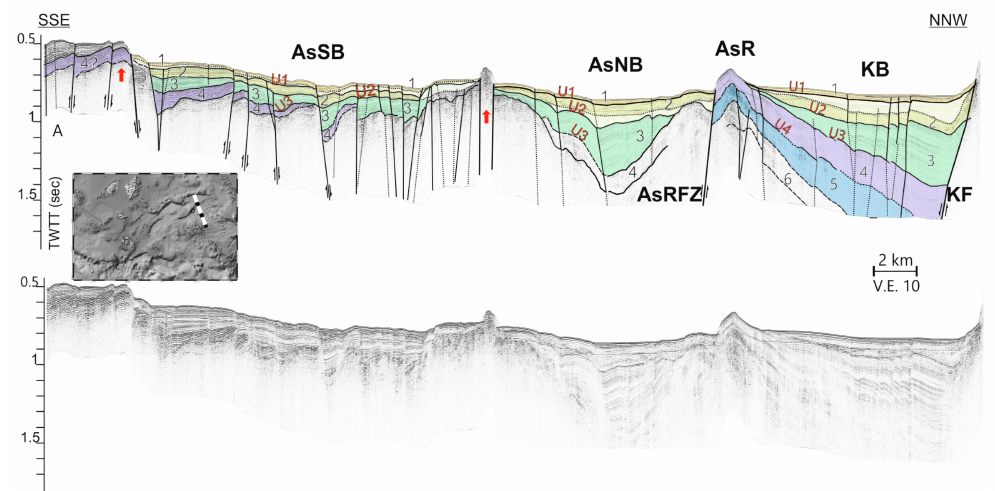
Figure 7. Airgun 40 ci seismic profile crossing the central part of Kinairos Basin (KB), the eastern part of Astypalea North Basin (AsNB), and Astypalea South Basin (AsSB). Terminology and symbols as in Figure 4. AsRF: Astypalea Ridge Fault, KF: Kinairos